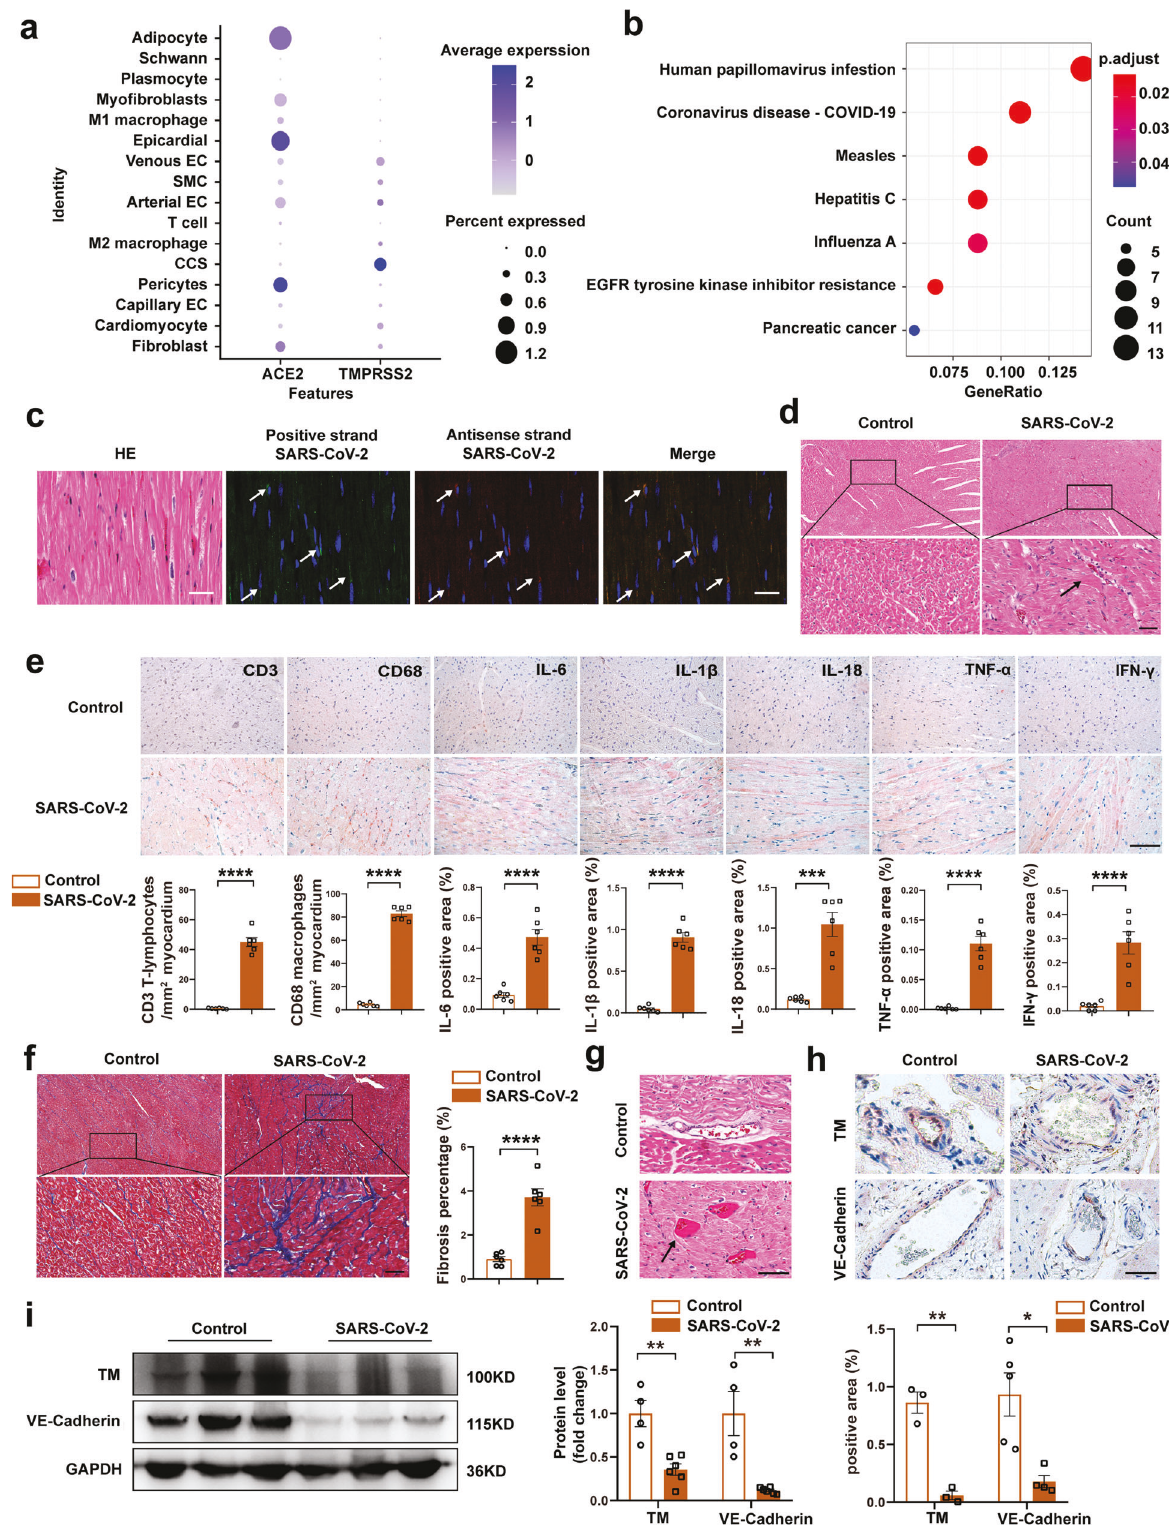
viral RNA copies (~1 × 10 4 copies/mL) were detected in the lungs, which also showed ground-glass opacity and obscure markings in the upper lobe of the right lung by X-ray. 3 Our fi ndings on SARS-CoV- 2-induced cardiac injury are particularly important, given that this animal model is used for vaccine testing and drug